Question: Give a one-sentence summary of this figure.
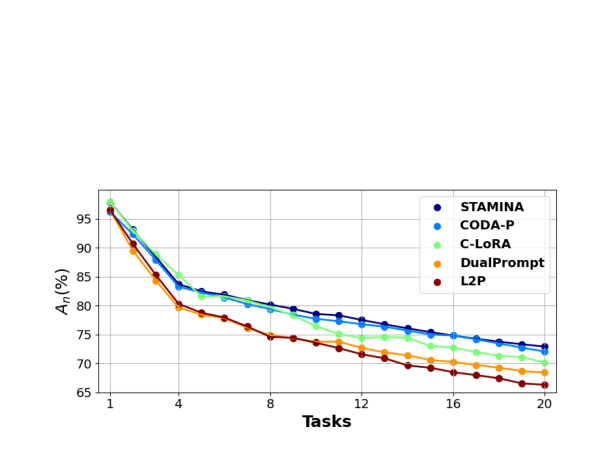
Answer: Image classification results on ImageNet-R [39, 62]. An gives the accuracy averaged over all seen tasks.